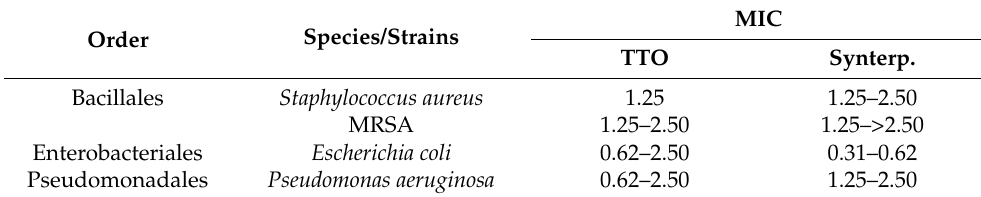
Table 3. Minimum inhibitory concentration (MIC) of TTO and Synterpicine™. MIC assays were per- formed on 4 Gram-positive and negative species. The range of concentrations tested is 0.00499–2.50% (v:v). TTO: tea tree oil; Synterp.: Synterpicine™; MRSA: methicillin-resistant Staphylococcus aureus ( n =